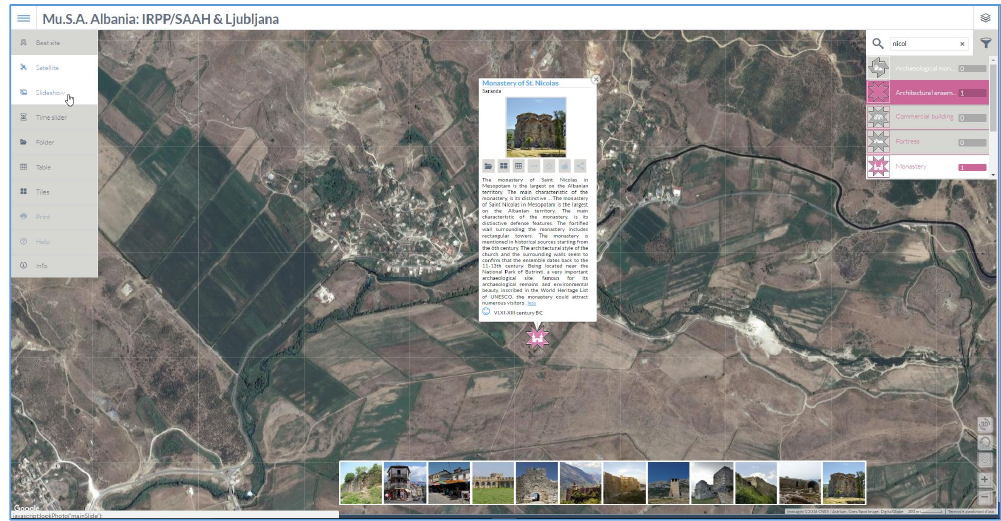
Figure 9. The interactive map (improved version for Albania)—the “Callout” with the extended description ( centre ). In the “Menu” (opened on the left ) the function “Satellite” and “Slideshow” are active, then the map is in earth view and the slideshow runs on bottom. The map shows only the PoI.s belonging to the “Architectural ensemble”, the only type switched-on in the sidebar ( right ).